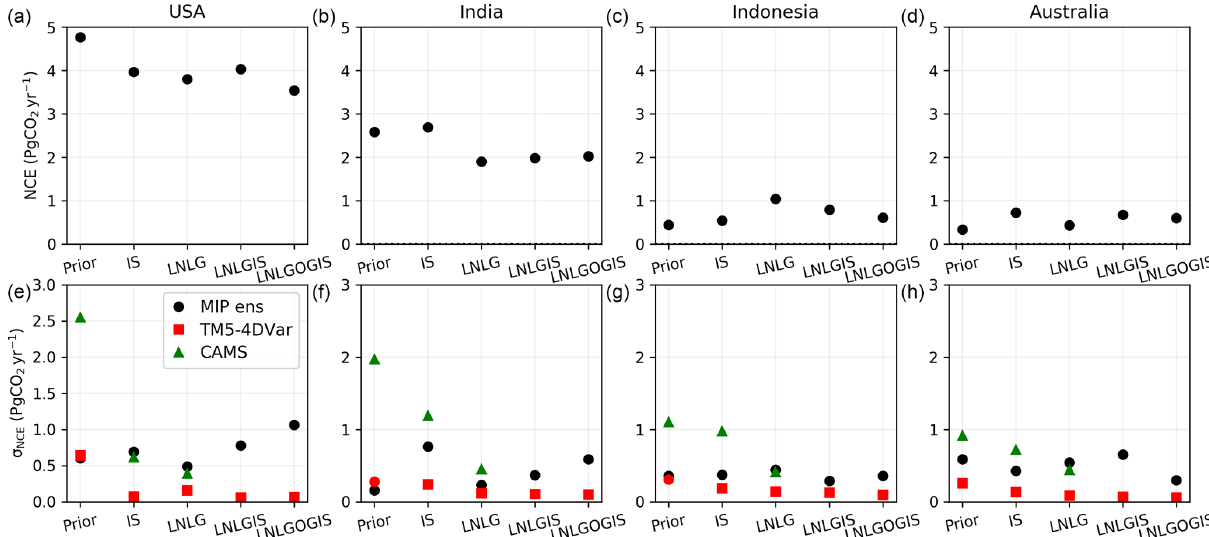
Figure 9. (a–d) NCE and (e–h) σ NCE for four countries in 2018. The v10 OCO-2 MIP ensemble-spread-based error estimate is shown in black, the TM5-4DVar Bayesian uncertainty estimate is shown in red and the CAMS Bayesian uncertainty estimate is shown in green (only for Prior, IS and LNLG).